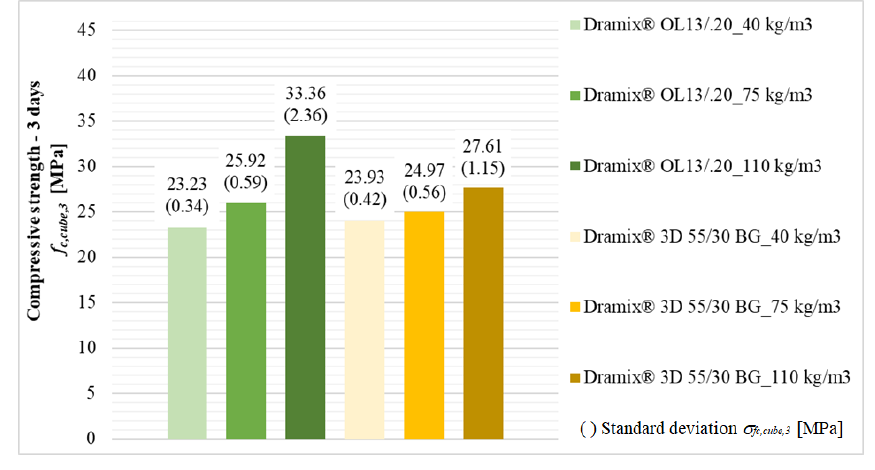
Figure 7. Three-day compressive strength of fiber-reinforced concrete.